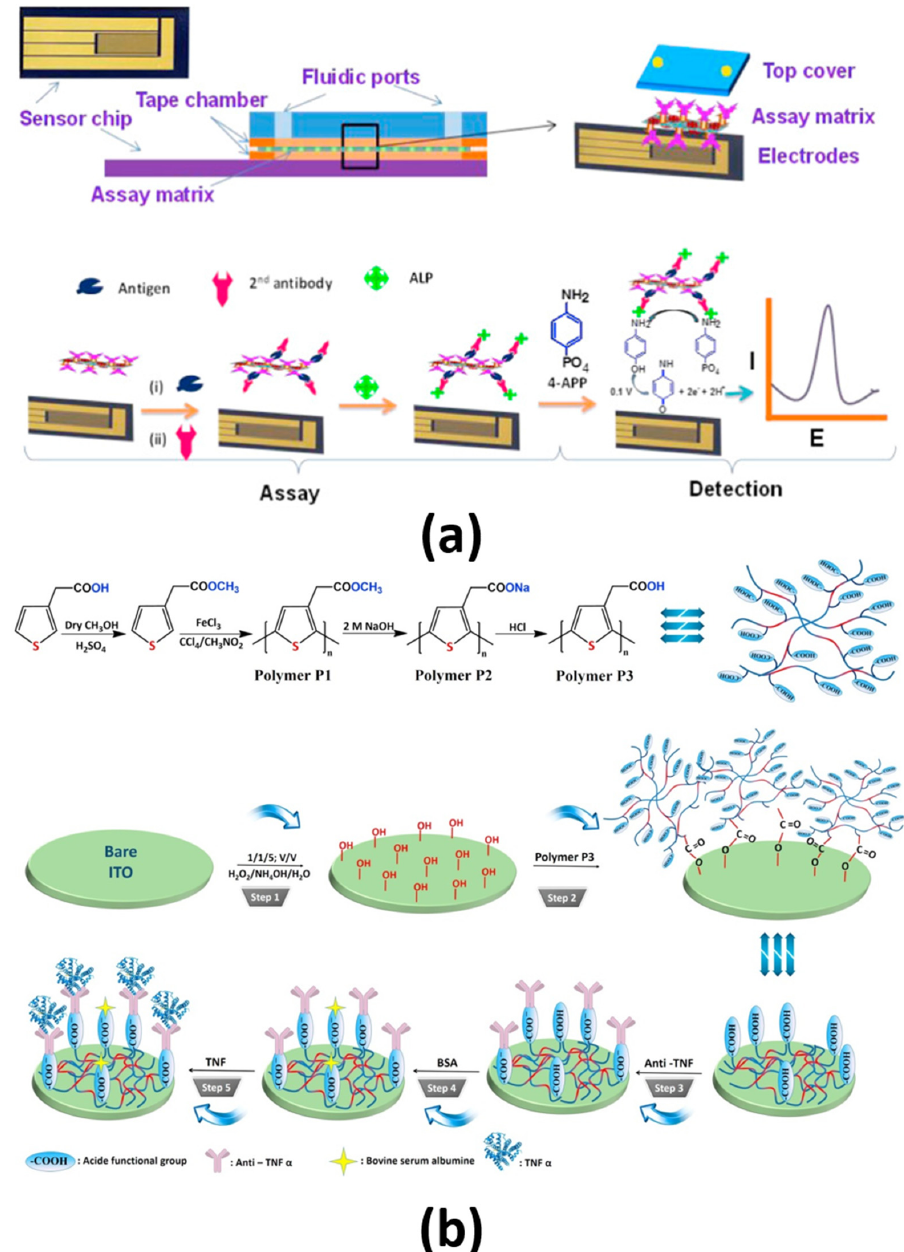
Figure 9. ( a ) Schematic display of the on-chip electrochemical immunoassay platform developed for the determination of TNF- α in undiluted serum using off-surface membrane matrix (upper row) and DPV detection in the presence of 4-APP (lower row). ( b ) Antibiofouling impedimetric ylated polymer-modified ITO thin film: polymer preparation (upper row) and immunosensor preparation and recognition (lower rows). Reproduced and adapted from ( a ) [36] and ( b ) [39] with